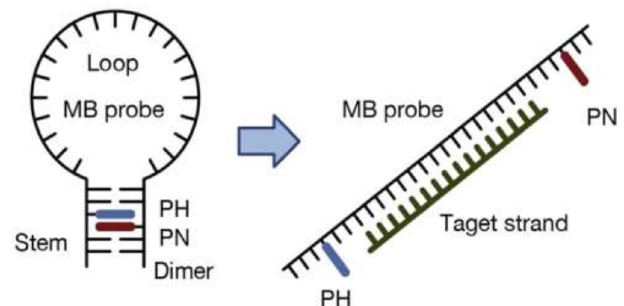
Figure 12. Structure of molecular beacon probe (MB) with a heterodimer based on a parent perylene diimide (PH) and pyrrolidine-substituted PDI in the stem region [72]. © 2018 Wiley-VCH Verlag GmbH & Co. KGaA,